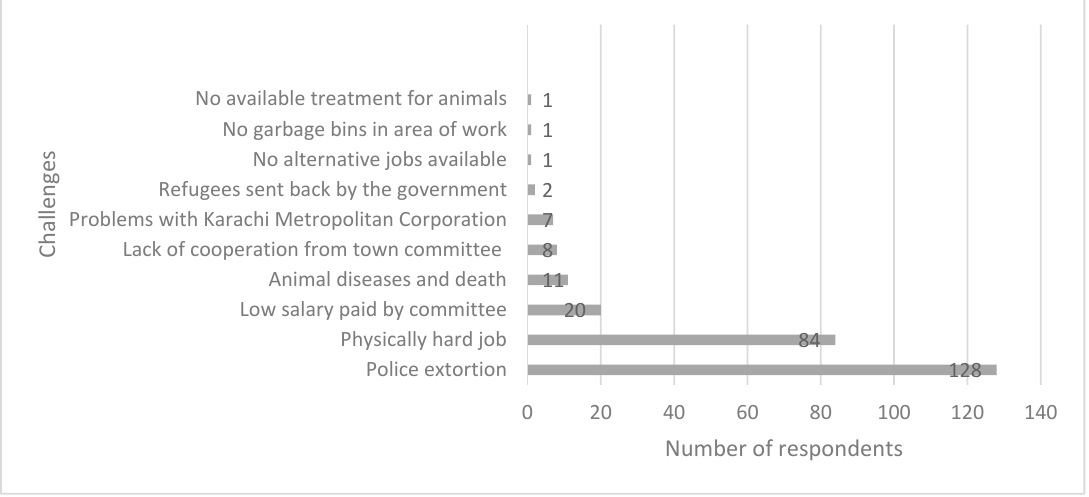
Figure 2. Challenges reported by donkey cart owners during waste management work. Note some participants gave more than one response, 283 challenges were reported.